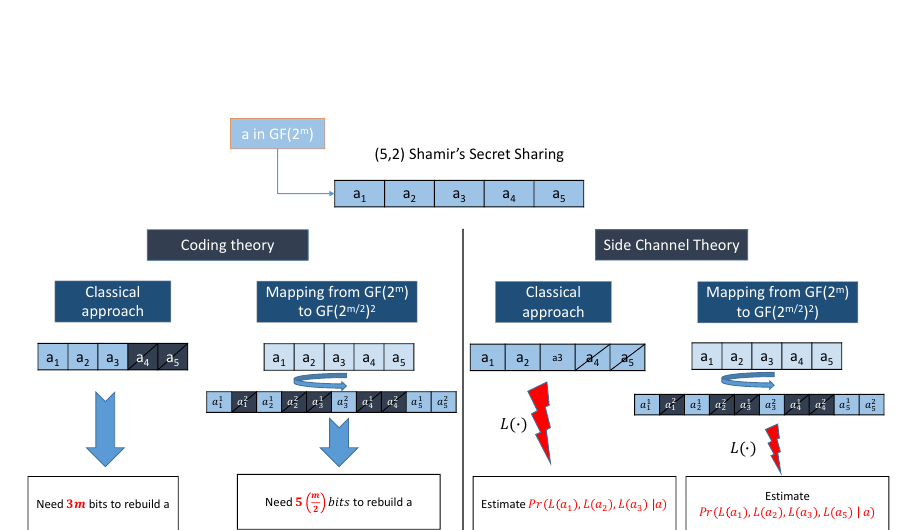
Figure 2: Side-channel and linear repairing codes for Shamir’s